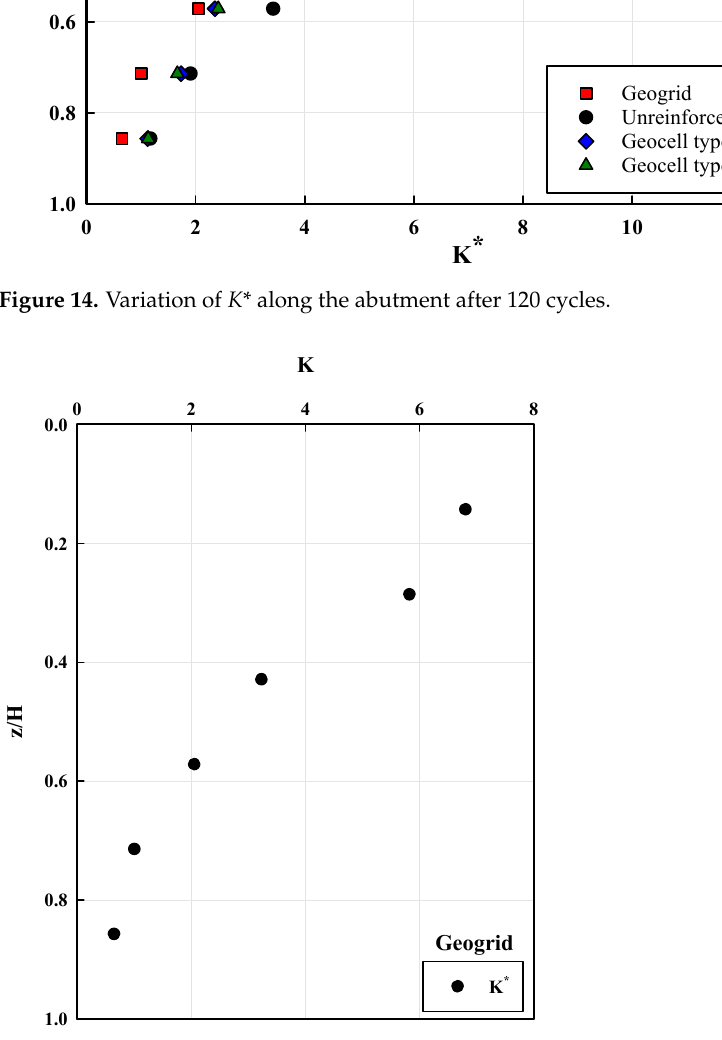
Figure 15. K * after 120 Figure 15. K* after 120 cycles.